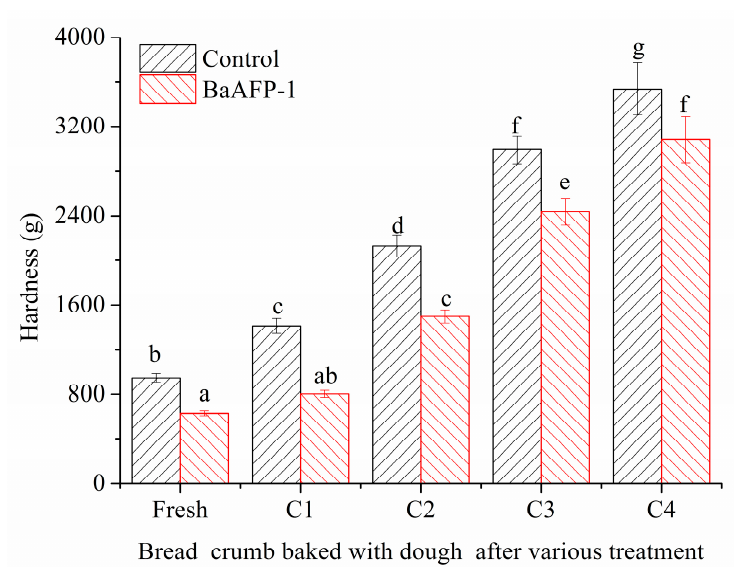
Figure 4. E ff ect of BaAFP-1 on the hardness of bread Figure 4. Effect of BaAFP-1 on the hardness of bread crumb.